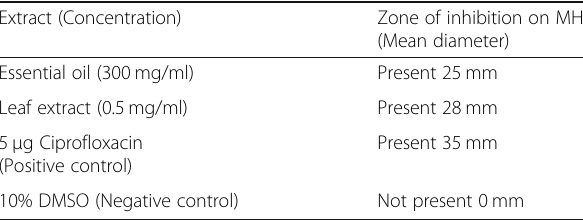
Table 4 Screening for antimicrobial activities of plant extracts against GBS isolates Extract (Concentration) Zone of inhibition on MH (Mean diameter) Essential oil (300 mg/ml) Present 25 mm